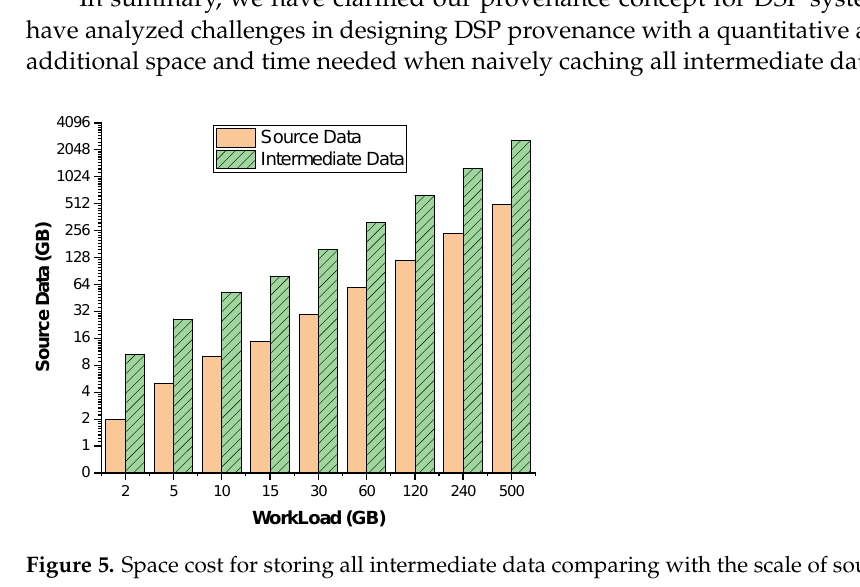
Figure 5. Space cost for storing all intermediate data comparing with the scale of source data. Both source data and intermediate data are on a logarithmic scale. The size of intermediate data is about 5.3 times as much as source data for all